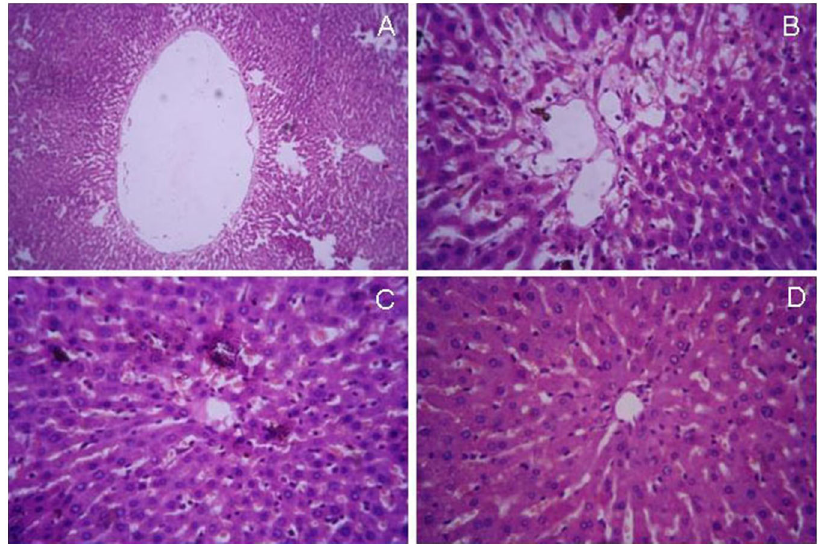
Figure 11. Histopathology examination of liver sections. (A) normal liver, (B) diabetic liver, (C) Sb treated liver (D) CSbnp treated liver (Magnification 100 6 ). Representative micrographs are shown.